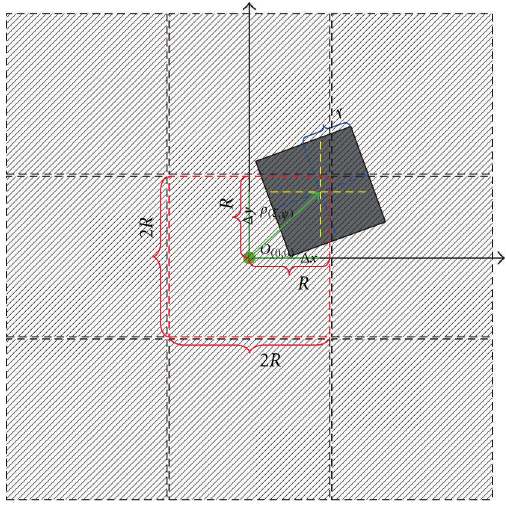
Figure 8: Variable demonstration.